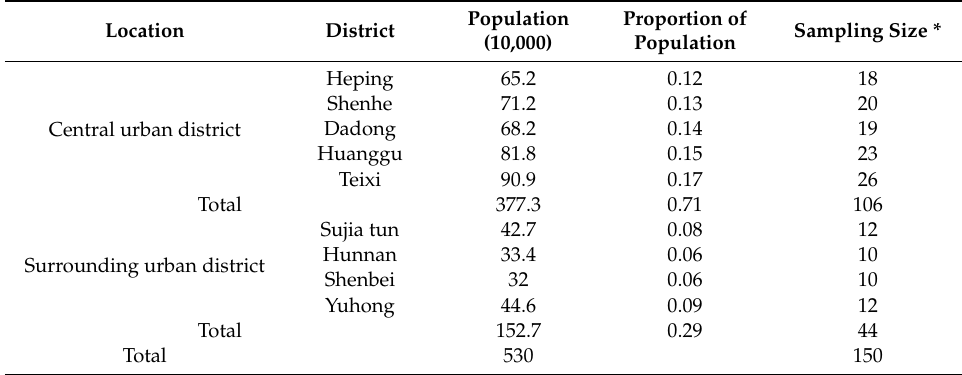
Table A3. Population Distribution and Sampling Number in Urban